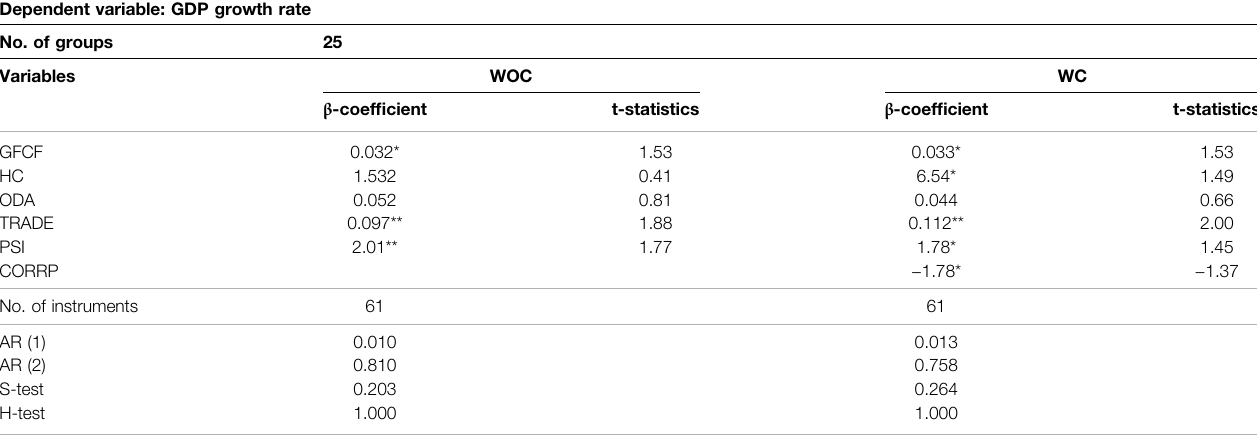
TABLE 8 | Results of difference GMM for sub-Saharan Africa.